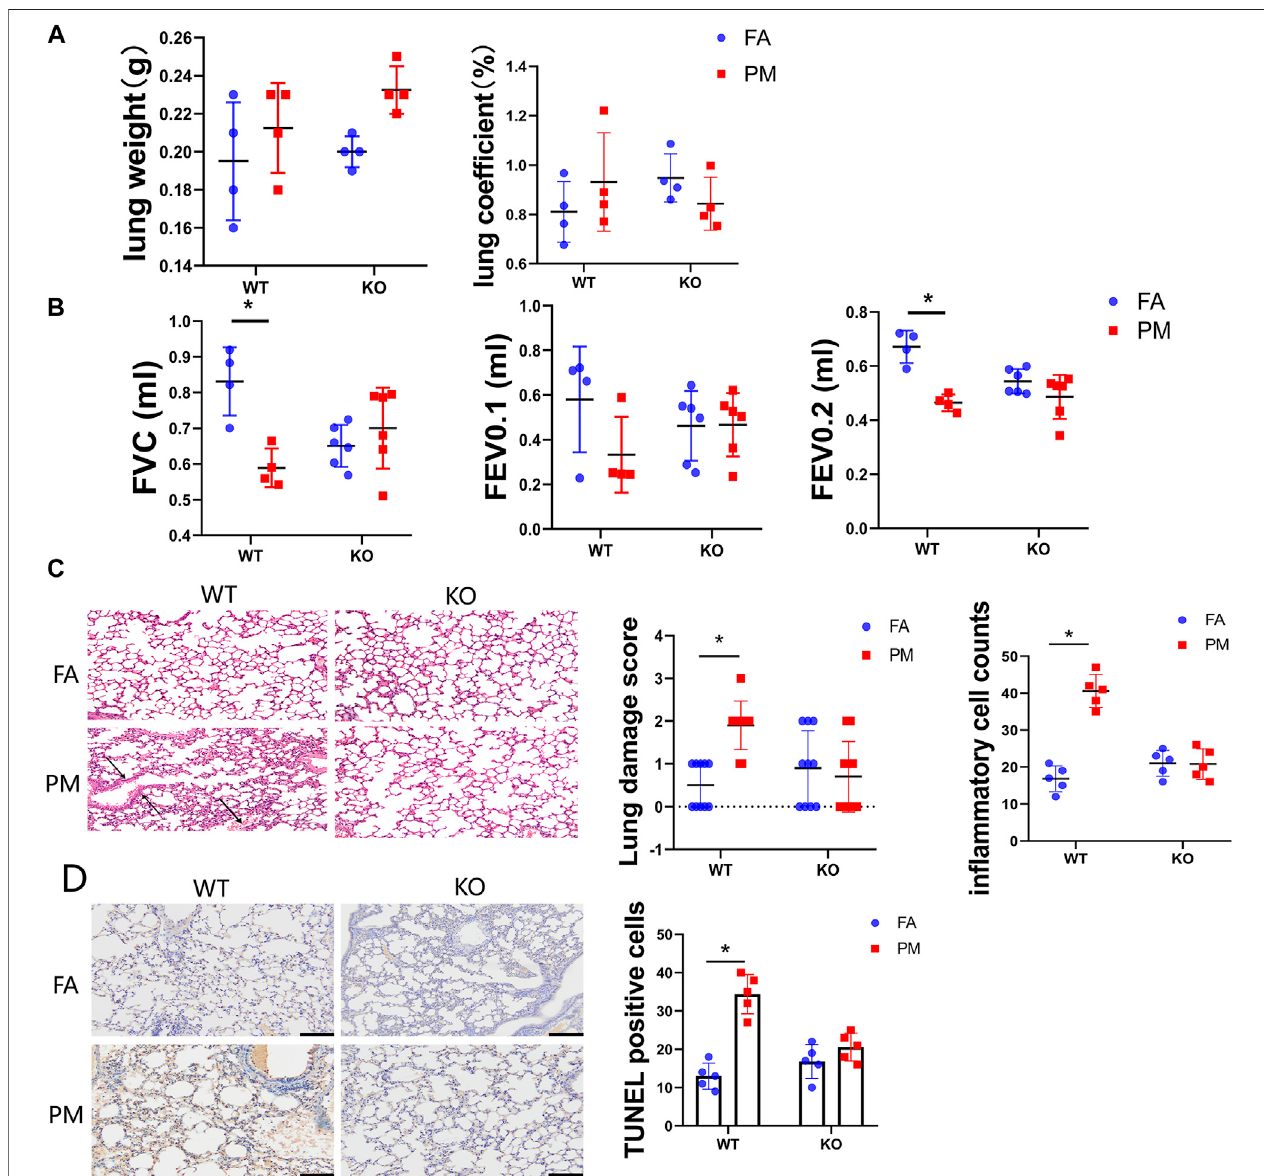
FIGURE 1 | Effects of Nrf2 knockout on pulmonary function and pathology in PM 2.5 -exposed mice. (A) The lung weight and ratio of lung to body weight of four groupsmiceafterthetreatment. n (cid:2) 4pereachgroup. (B) Thetracheasofmicewereconnectedtotheinstrumentmeasuringpulmonaryfunctionunderanaesthesia( n (cid:2) 6), and the indicators of lung function were monitored by instrument. Lung function parameters: FVC, forced vital capacity; FEV0.1, forced expiratory volume in the fi rst 0.1 ° s; FEV0.2, forced expiratory volume in the fi rst 0.2 ° s. (C) Lung was isolated, fi xed, sectioned, and observed microscopically after hematoxylin and eosin (H&E) staining (representative of four mice, magni fi cation × 200). The lung injury scores and in fl ammatory cells counts were calculated in different groups of mice. (D) Lung tissue sections from four groups mice were isolated and test the apoptosis cells by TUNEL assay kit. The TUNEL positive cells were quanti fi ed with ImageJ (NIH, United States) software. FA, fi ltered air; PM, fi ne particulate matter. WT, wild type mice; KO, Nrf2 − / − mice. Scale bars are 50 ° μ m, and magni fi cation is × 200. Data are expressed as the mean ± SEM, * p <